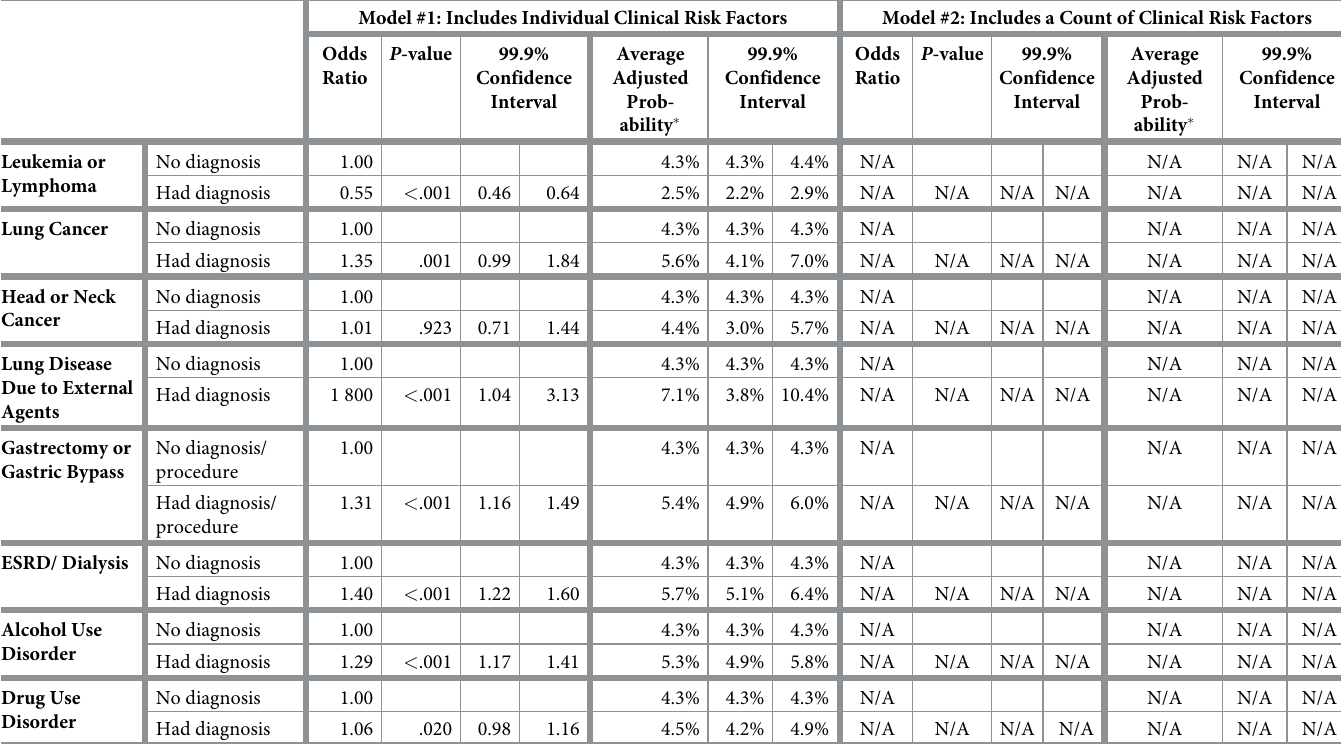
(cid:3) Calculated as the average predicted probability of a test conditional on all observations being in the category represented by the row. The difference between the predicted probabilities for two categories of a given categorical variable represents the average marginal effect. (cid:3)(cid:3) The percent of households in county with income under FPL, percent of foreign-born individuals in county, and the state TB rate were entered into the models as continuous variables. Average predicted probability of Mycobacterium tuberculosis screening at the minimum, maximum, and quartile values of these variables can be found in Table 4. (cid:3)(cid:3)(cid:3) Unit of increase is 1 per